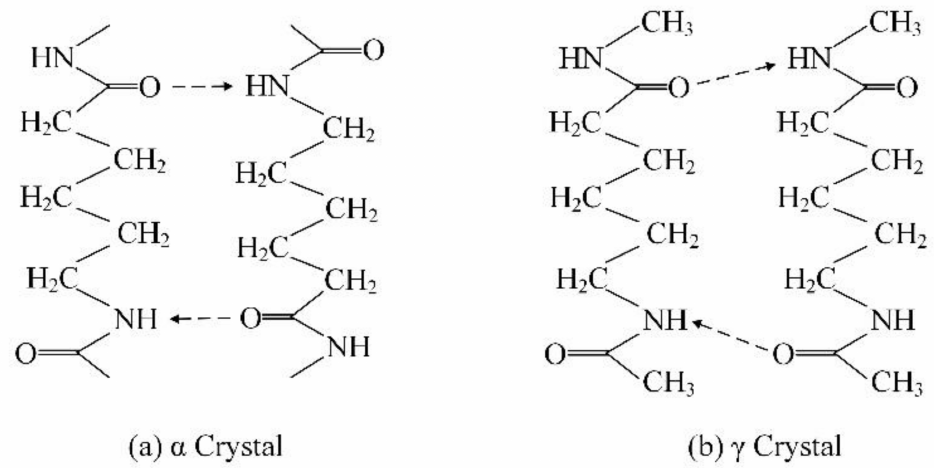
Figure 6. Crystal structures of the α crystal type and the γ crystal type. In order to obtain suitable temperature parameters, different injection temperatures were applied in the injection-molding process of the composite parts. The injection pressure was 8 MPa, the holding pressure was 5 MPa, and the holding time was 2.5 s. The injection temperatures were 230 ◦ C, 240 ◦ C, and 250 ◦ C, respectively. The tensile strength of the are shown in Figure 7. When the injection temperature increased from 230 ◦ C to 240 ◦ C, the tensile strength increased from 5.59 MPa to 8.54 MPa. When the injection temperature increased from 240 ◦ C to 250 ◦ C, the tensile strength decreased from 8.54 MPa to 7.27 MPa. Therefore, the composite parts demonstrated a good injection molding quality and high tensile strength when the injection temperature was 240 ◦